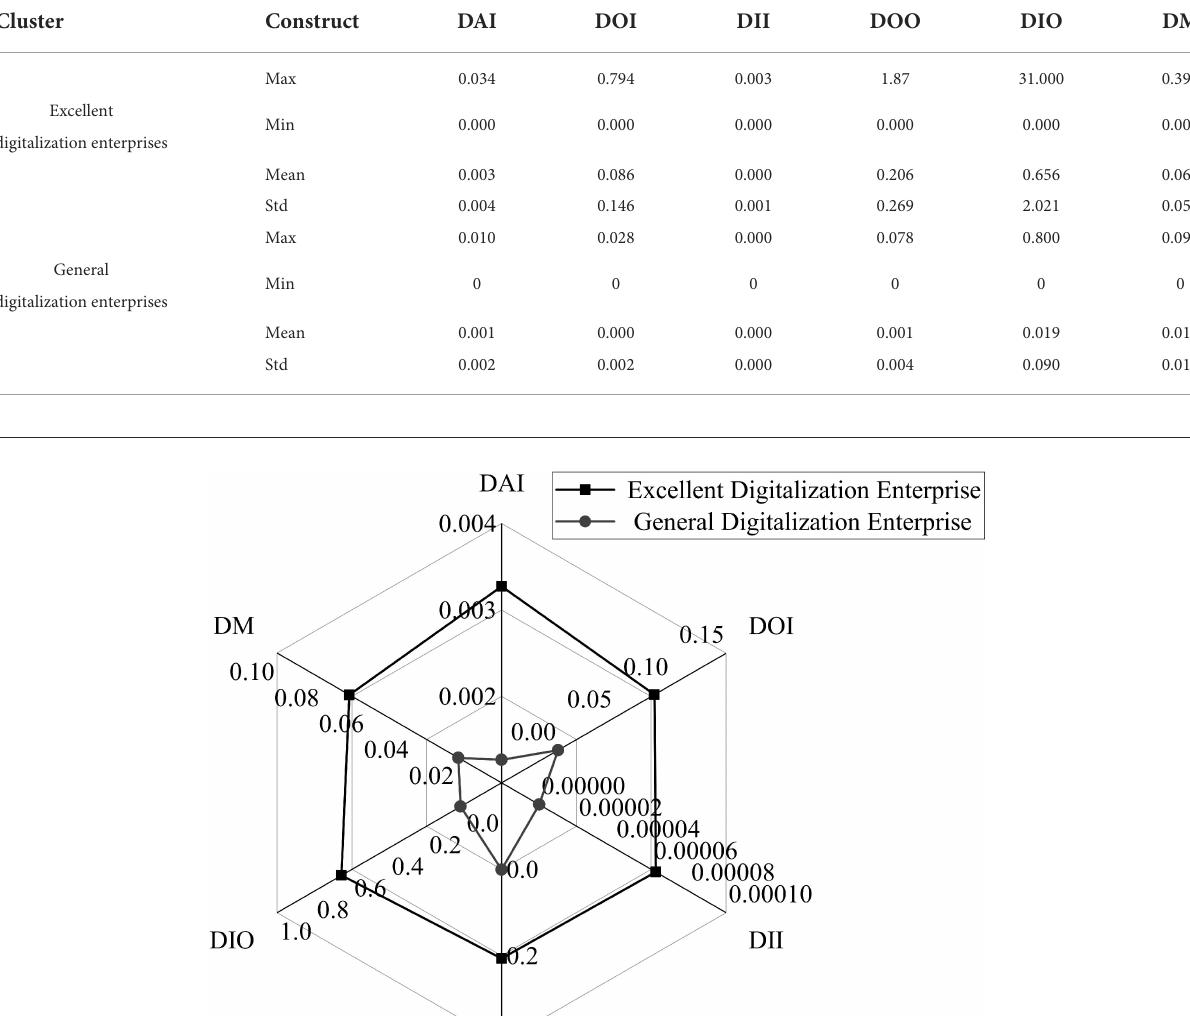
TABLE 2 Descriptive statistics table of enterprise digitalization features under clustering results.